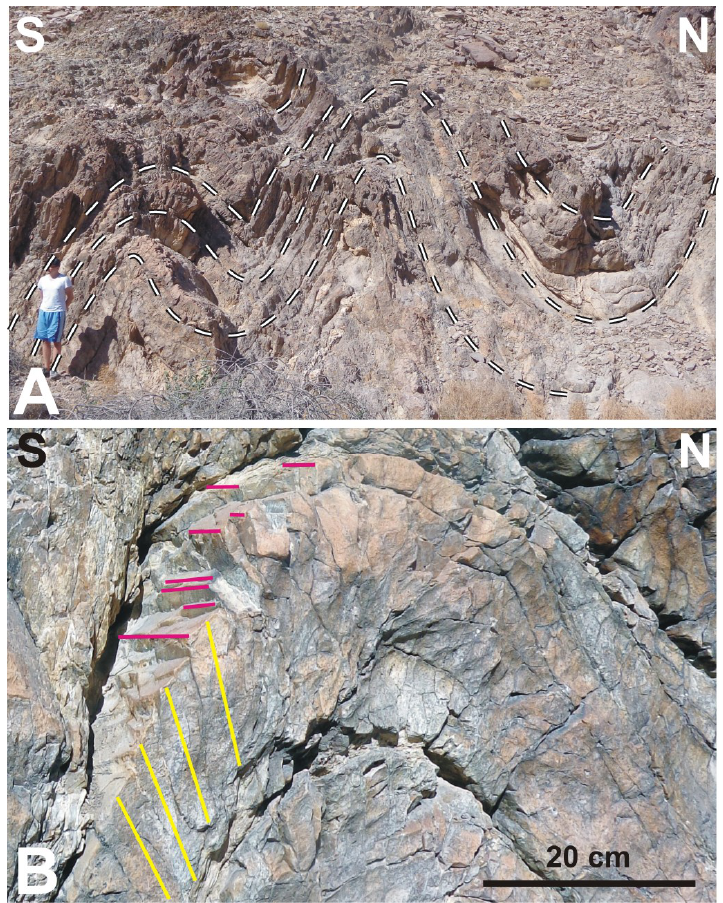
Figure 8. Folds in quartzites of Am 2 with thickened hinge areas and thinned limbs in Wadi Qahza. ( A ) Typical open folds with vertical or steeply dipping fold axial planes. The folds are clarified by white dashed lines. ( B ) Anticline with bedding and fold-related cleavage (S 1 ). The steeply dipping cleavage is marked by yellow lines. The intersection lineations between bedding and cleavage (indicated by red lines) are parallel to the fold axes. Coordinates: 23°19'29.62" N/58°22'58.52" E.